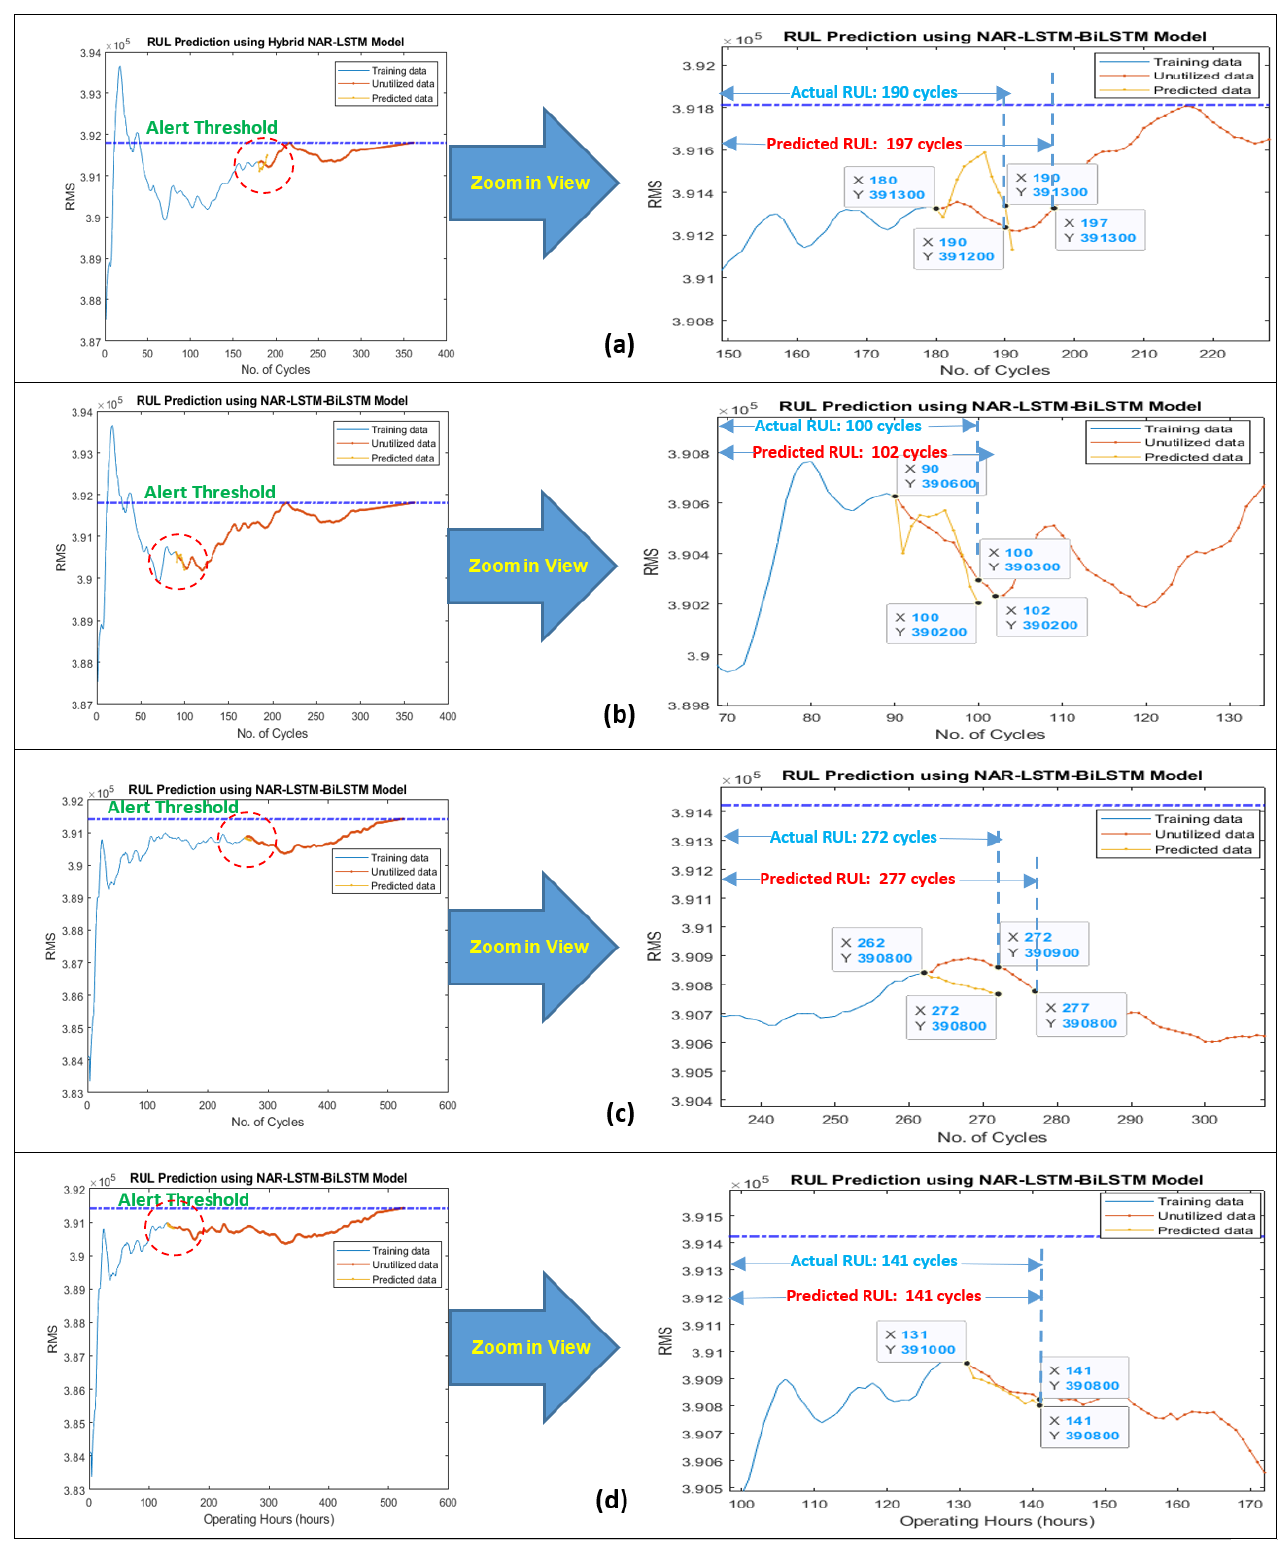
Figure 14. Prediction of short-term RUL for the next 10 h of turbofan jet engines using FD002 for ( a ) 50% and ( b ) 25% data of engine No. 140 degradation trends and FD004 for ( c ) 50% and ( d ) 25% data of engine No. 25 degradation trends.